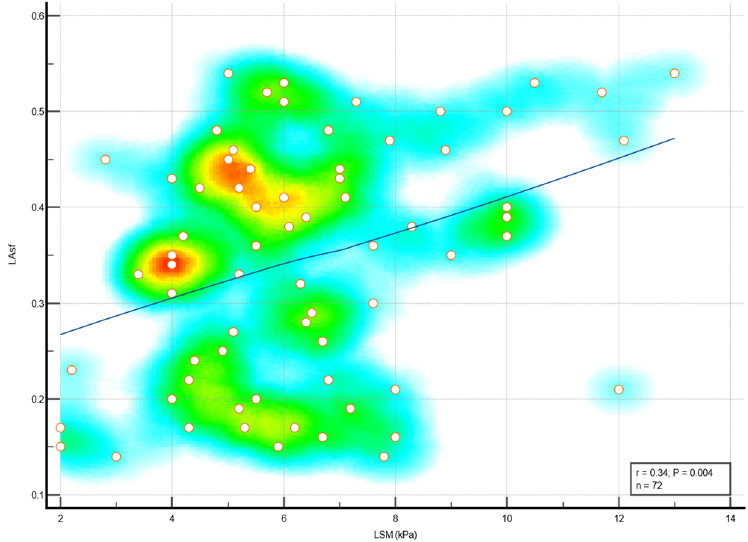
Figure 4. Correlation between LSM and LA stiffness in diabetic MetS subjects. Abbreviations: MetS,